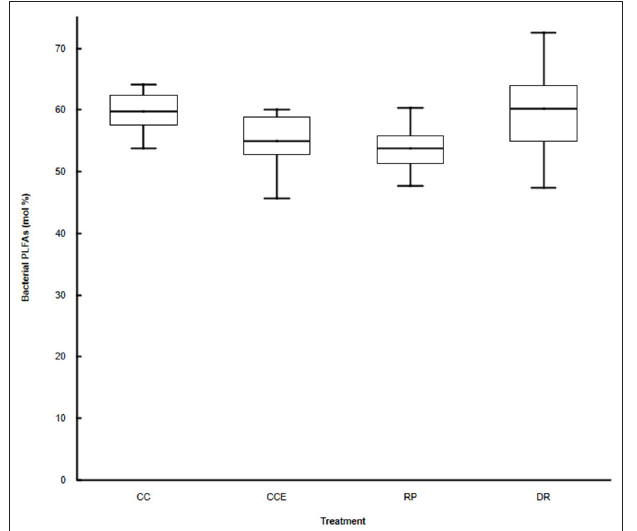
FIGURE 3 | Bacterial abundance (expressed as mol% bacterial PLFAs) in the dispersed-retention (DR) treatment, the retention patch (RP), in the clear-cut treatment (CC, 9m, or more from the retention patch) and in the clear-cut edge treatment (CCE, within 9m of the retention patch).